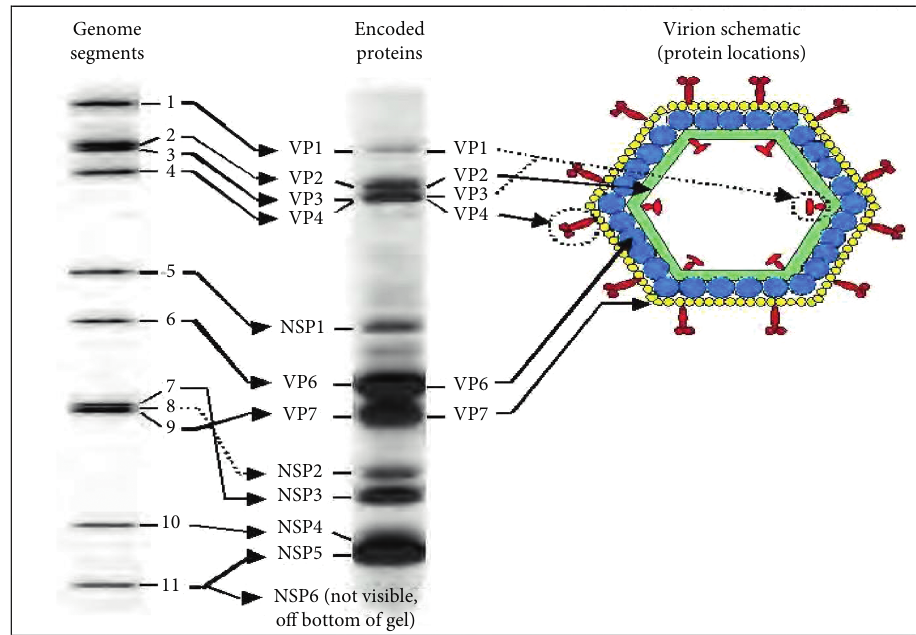
Figure 1: Diagrammatic representation of the rotavirus particle and its genome coding. (I) The migration pattern of 11 dsRNA genome segments of rotavirus on a polyacrylamide gel. (II) Virus proteins encoded by specific genome segments in Section 1. The proteins were blotted onto a cellulose membrane and detected with rotavirus-specific antibodies. (III) Schematic diagram of rotavirus particle showing the cross section arrangement of viral proteins through the three capsid layers namely: outer (VP4, red; VP7, yellow), inner (VP6, blue) and the inner core (VP2, green). Source: [23]. Table 1: Rotavirus proteins, genome segments, and structural